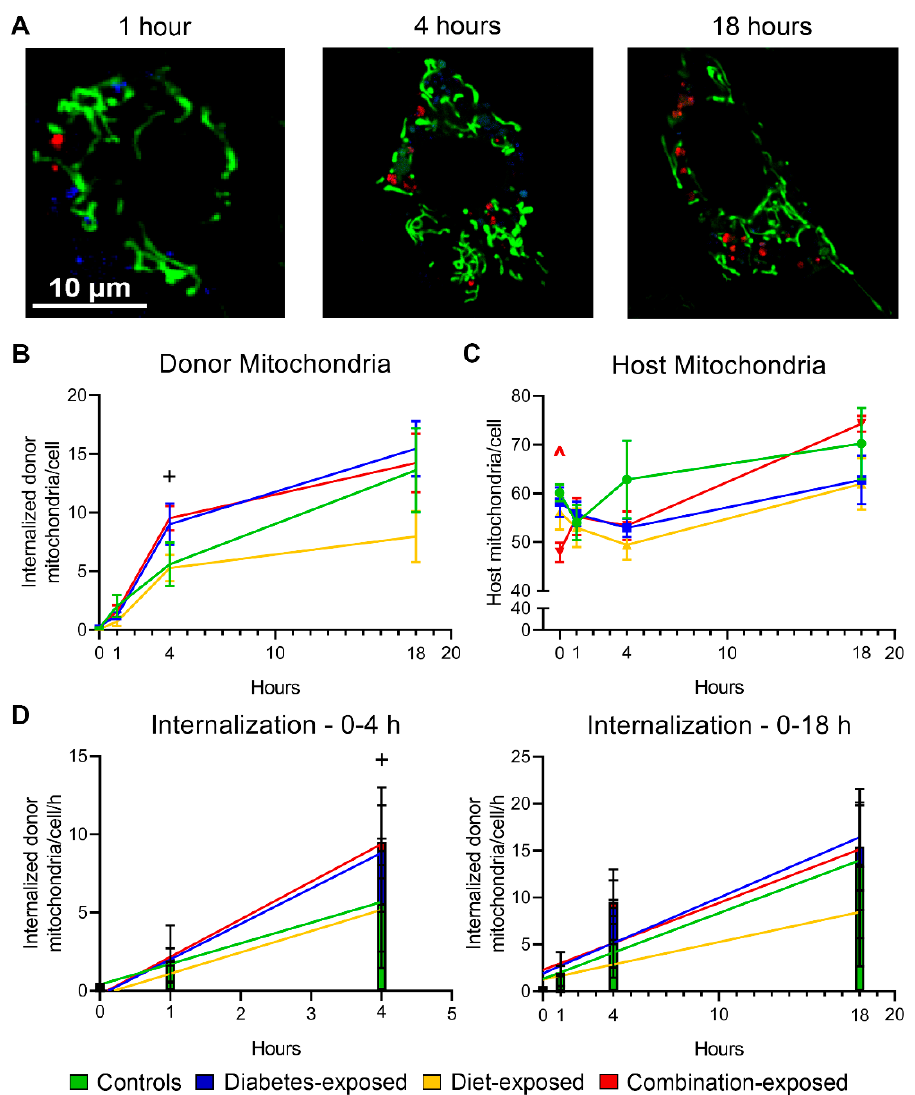
Figure 2. Donor mitochondria are internalized by cardiomyocytes at faster rates with diabetes exposure. ( A ) Representative confocal live-cell images of MitoTracker Green- and LysoTracker Blue-stained cardiomyocytes co-incubated with pHrodo Red-stained donor mitochondria. Numbers of internalized donor mitochondria ( B ) and host mitochondria ( C ) over time. ( D ) Rates of donor mitochondria internalization in the first four hours of co-incubation (left) and across 18 h (right). Data represent mean ± SEM. N=5–6 males/group. Significant differences ( p ≤ 0.05): + diabetes effect by 2-way ANOVA, ^group effect by 1-way ANOVA and Dunnett post hoc test when interaction was present by 2-way ANOVA.